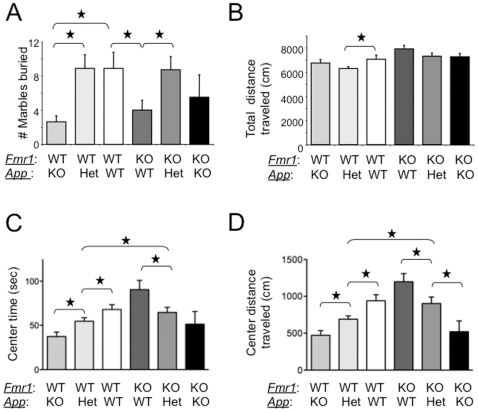
Rescue of behavioral phenotypes in adult Fmr1KO mice by genetic manipulation of App.(A) male AppKO (n = 8), AppHET (n = 14), WT (n = 7), Fmr-1KO (n = 8), Fmr1KO/AppHET (n = 10) and Fmr1KO/AppKO (n = 4) mice (8–10 weeks old) were assessed for marble burying activity. Statistics: one-way ANOVA p<0.022, F = 2.95. (B, C and D) Mice were assessed for anxiety levels and locomotion in the open field. Both genders were included as the males and females exhibited equivalent locomotion and anxiety in the open field [AppKO (n = 11), AppHET(n = 23), WT (n = 15), Fmr1KO (n = 14), Fmr-1KO/AppHET (n = 18) and Fmr1KO/AppKO (n = 7)]. (B) Total distance (cm) traveled is plotted against mouse strain. Statistics: one-way ANOVA p<0.0005, F = 4.59. (C) Time (sec) spent in the center of the arena is plotted versus mouse strain. Statistics: one-way ANOVA p<0.0001, F = 5.98. (D) Distance (cm) traveled in the center of the arena is plotted versus mouse strain. Statistics: one-way ANOVA p<0.0001, F = 9.17. Stars (★) denote statistically different levels by Student T-test analyses (p<0.5). All error bars represent SEM.